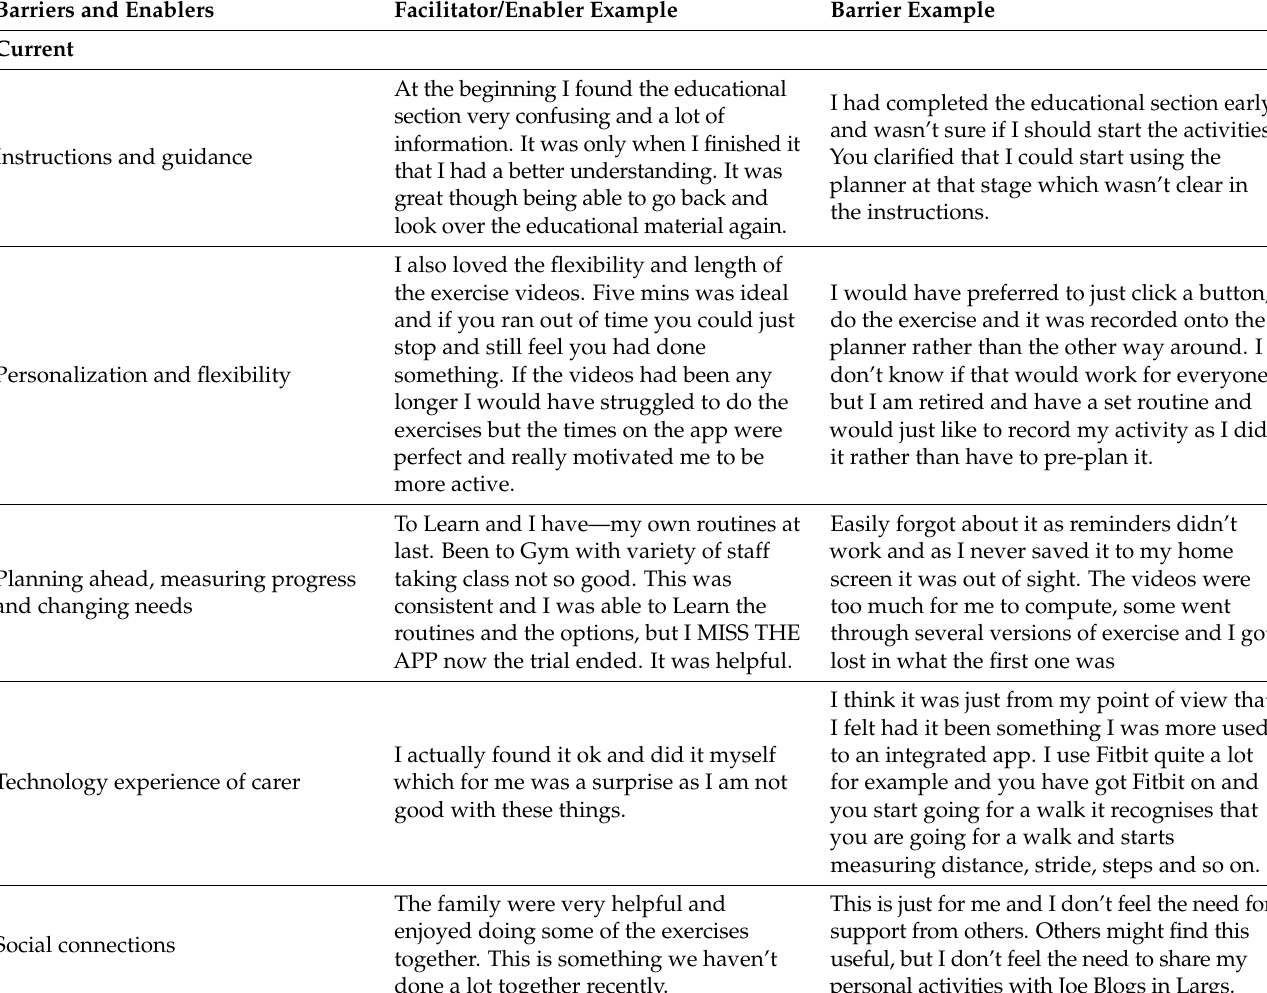
Table A3. Qualitative feedback of the barriers and enablers for use of